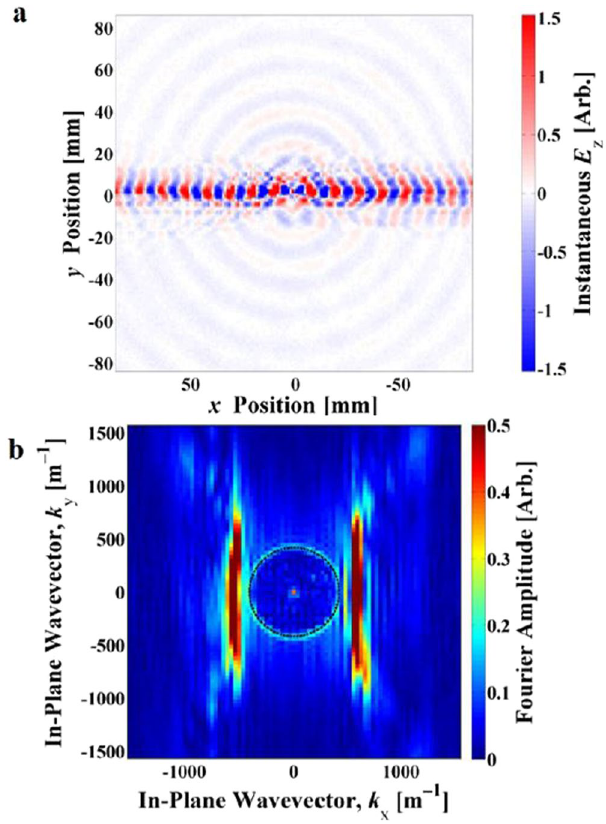
Figure 2. Experimental near-field scan results showing beaming at 20.00 GHz, with the excitation at the centre of the plot. ( a ) Real space plot of the normal component of the instantaneous electric field, E z ; ( b ) Iso-frequency contour plot showing the Fourier amplitude of the in-plane wave vector components of the surface wave - flat contours indicate beaming. Colour scales are